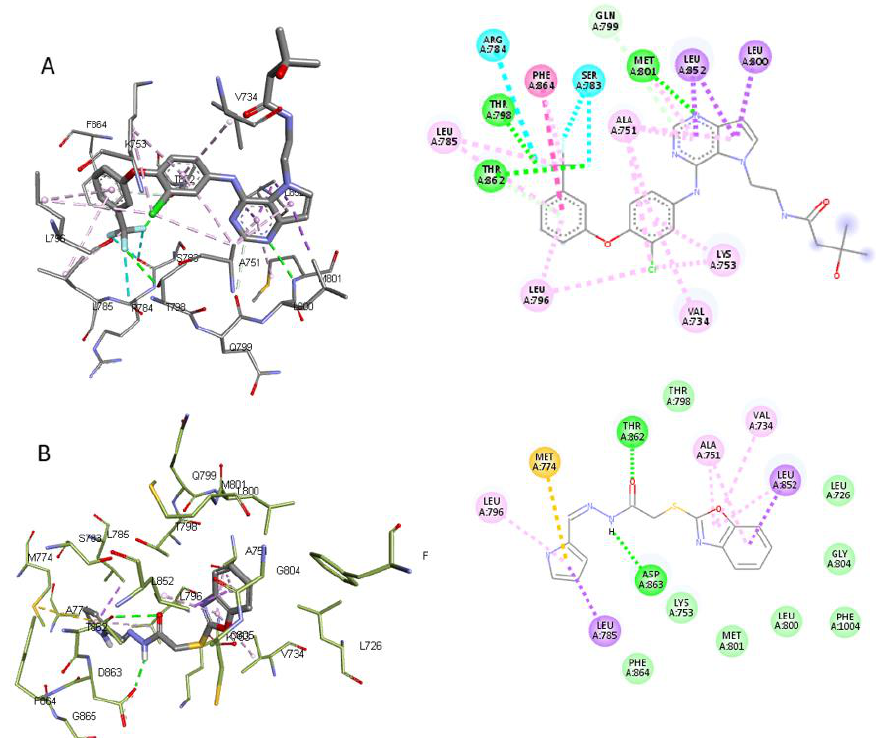
Figure 4. Schematic 2D and 3D depictions of the molecular simulation of lapatinib ( A ) and compound 6b ( B ) within the ATP-binding site of HER2 (PDB ID: 3RCD). Green dotted lines represent hydrogen bonding.